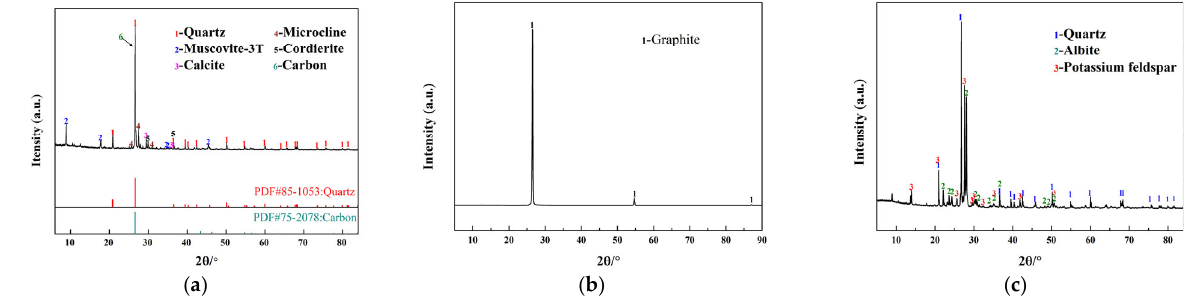
Figure 1. XRD pattern of ( a ) graphite tailings, ( b ) carbon, and ( c ) potassium feldspar.